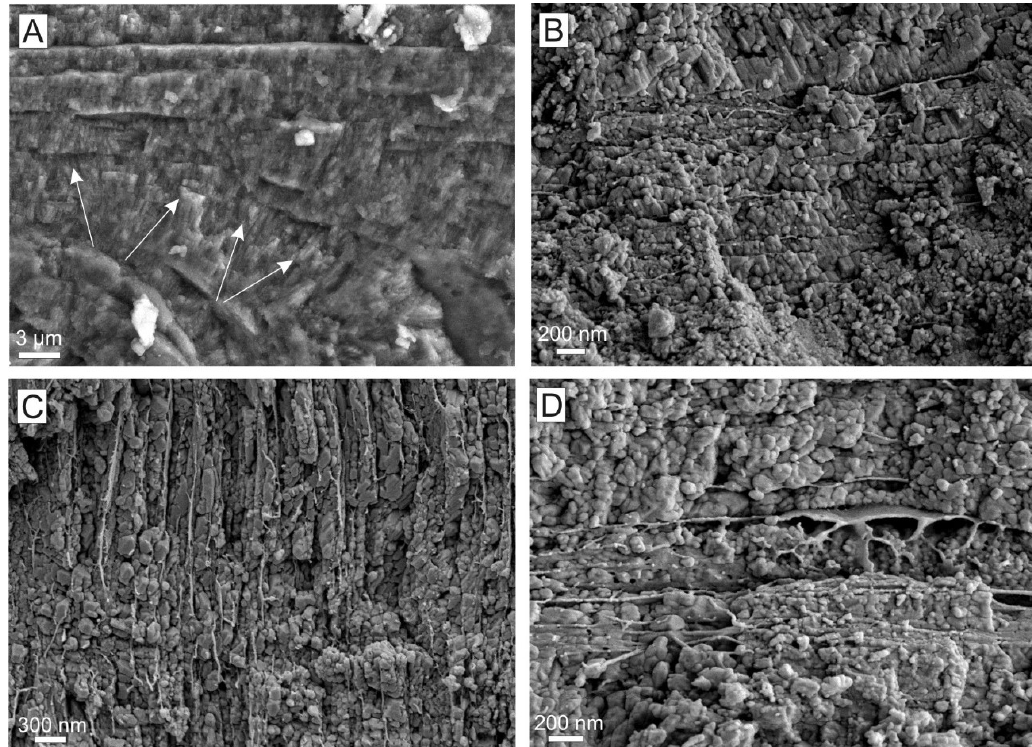
Figure 15. SEM images of fibrous and radial aragonite crystals of the prong. ( A ) Some laminae in the apical area pinch out laterally and disappear (white arrows) (SP-14). ( B – D ) Fibrous aragonite crystals at nanoscale are composed of clusters of small aragonite crystalline units, which are aligned. Among these crystals there are thin organic films (SP-15).